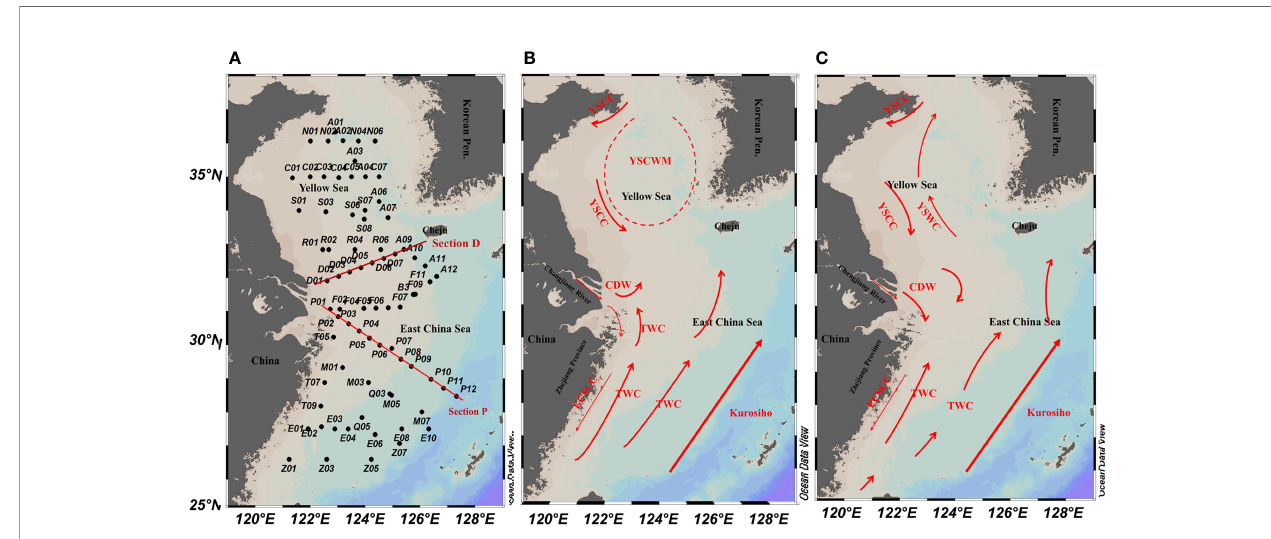
FIGURE 1 | Schematic of the circulation and (A) sampling stations in the East China Sea and southern Yellow Sea in (B) warm (summer and autumn) and (C) cold (winter and spring) seasons (Su and Yuan, 2005; Zhang et al., 2008; Chen,